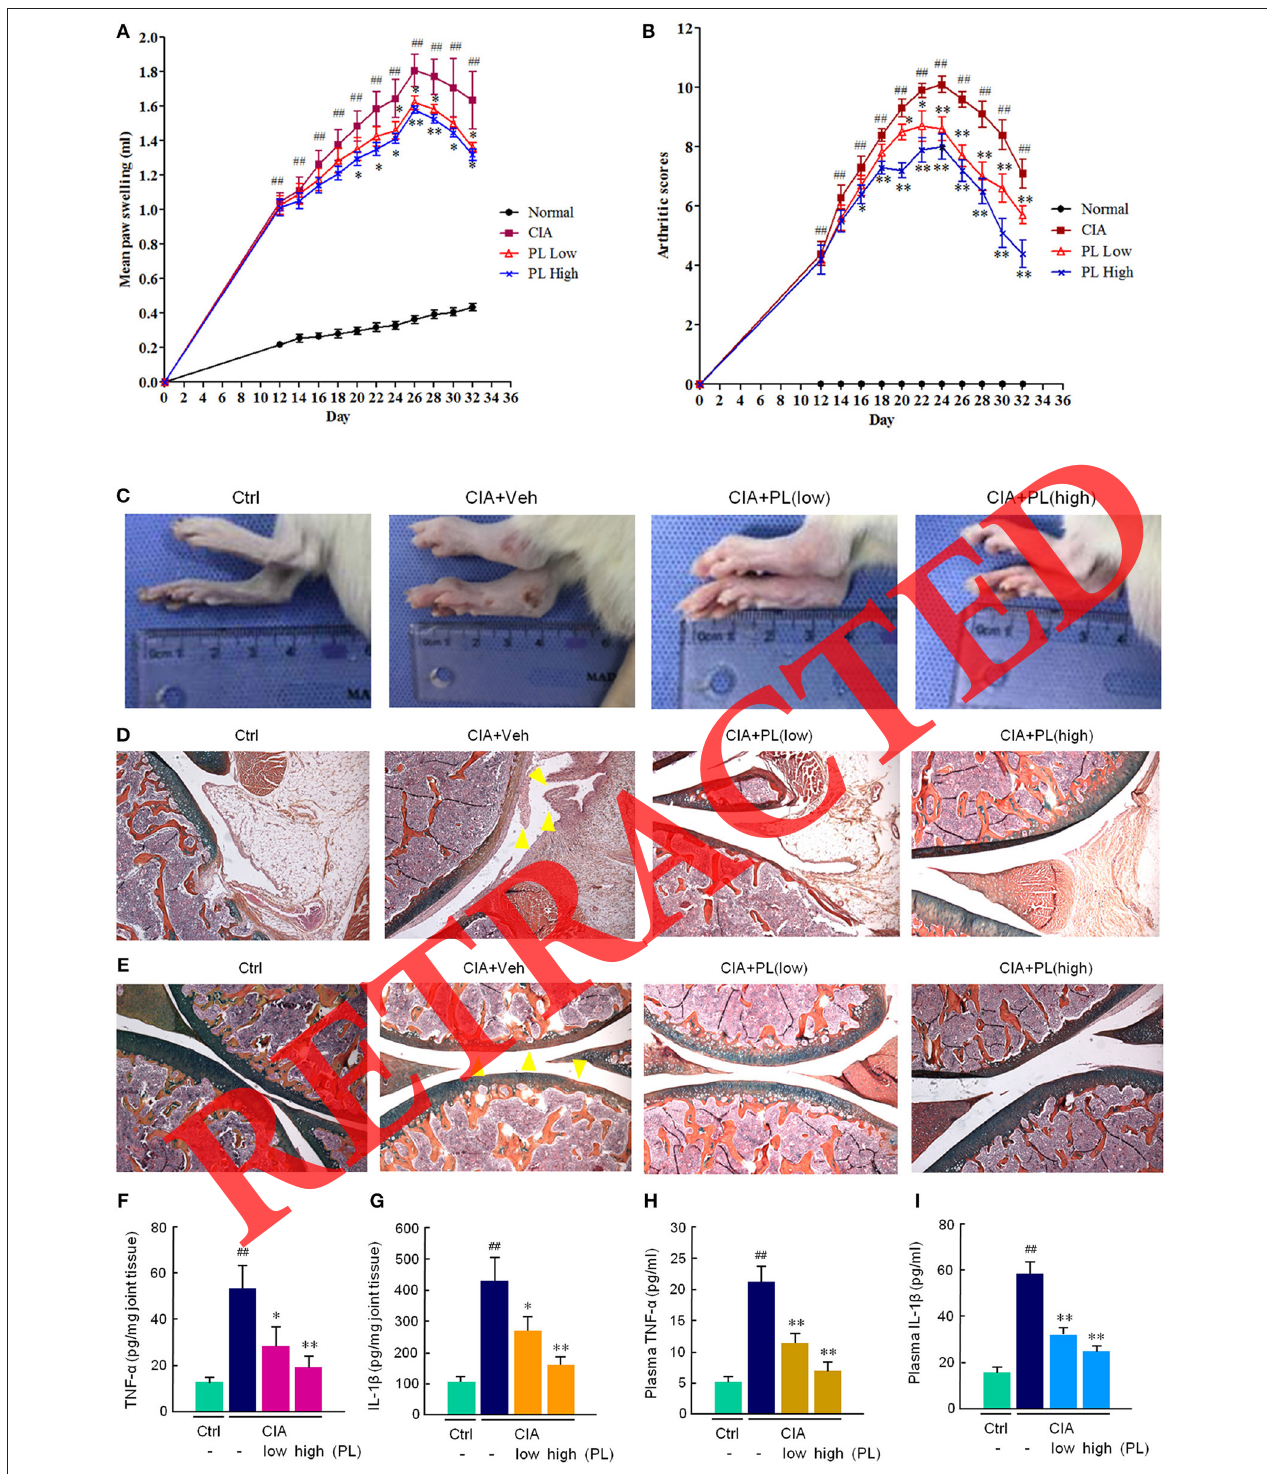
FIGURE 1 | Plumbagin (PL) treatment suppresses inflammatory arthritis in rats with collagen-induced arthritis (CIA). (A,B) Hind paw swelling measurement and time course of clinical arthritis in non-arthritic control rats (Ctrl), vehicle-treated CIA (CIA + Veh) rats, and CIA rats treated with low and high doses of plumbagin [CIA + PL(low) and CIA + PL(high)]. (C) Representative images of paw swelling. (D,E) Representative images of Alcian blue/H&E Orange G stained knee sections from different groups (original magnification × 50). Yellow arrowheads indicate sites of synovitis (D) and cartilage degradation (E) . (F,G) Protein levels of TNF- α and IL-1